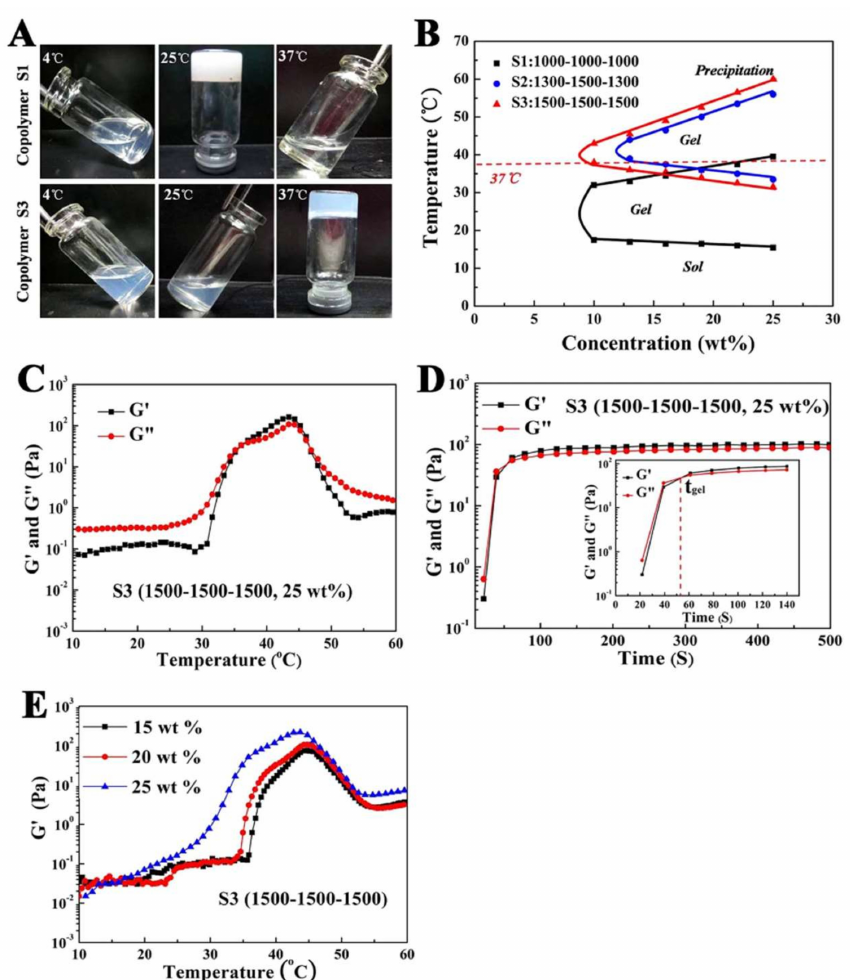
Figure 8. The thermogelling behavior assay and rheological analysis of the obtained. PDLLA-PEG- PDLLA hydrogel. ( A ) Photographs of the copolymer solutions at different temperatures. Copolymer L1000–E1000–L1000 (S1, 25 wt.%) gelates between 4 ◦ C and room temperature and precipitated around 37 ◦ C. Copolymer L1500–E1500–L1500 (S3, 25 wt.%) exhibited a sol at 4 ◦ C and room temperature, and gelated around body temperature. ( B ) Sol–gel phase transition diagram of the hydrogel tested by the tube-inverting method. ( C ) Temperature dependence of storage (G’) and loss modulus (G”) for the copolymer aqueous solution (S3, 25 wt.%) as a function of temperature. ( D ) Gelation times of the copolymer solutions (S3, 25 wt.%) at 37 ◦ C. ( E ) Change in G’ of the copolymer solutions at different concentrations (S3, 15 wt.%, 20 wt.%, 25 wt.%) as a function of temperature. Obtained from reference [143]. Copyright © 2022, The Authors, Springer